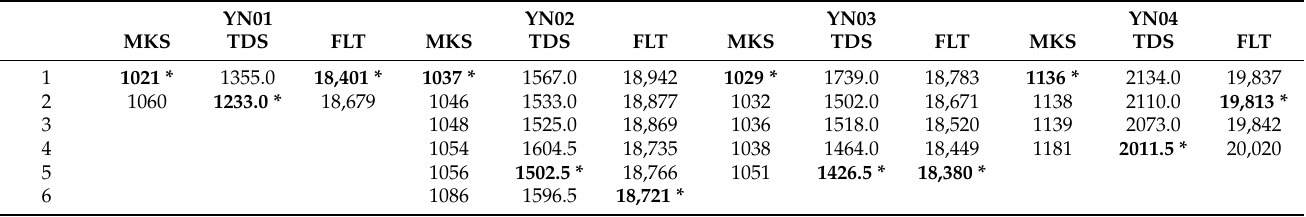
Table A11. Non-dominated solutions obtained by SS/CMOSA for the JSSP instances proposed by [40].